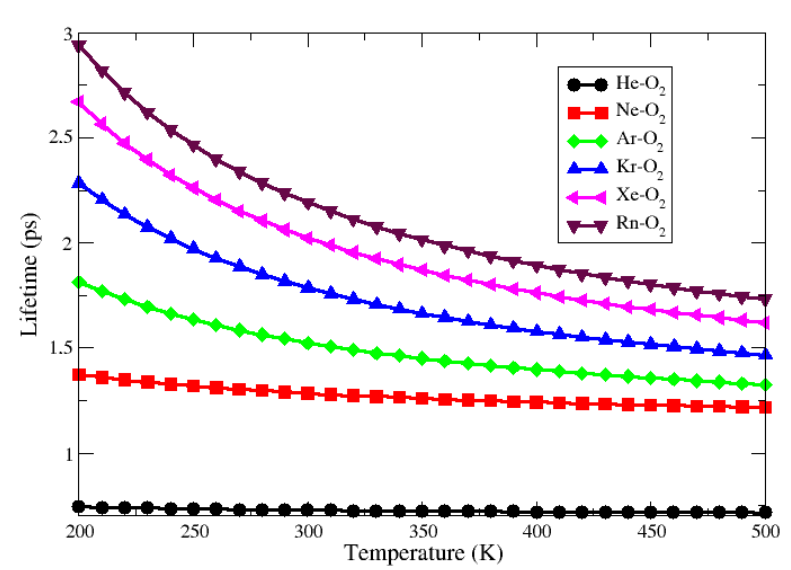
Figure 6. Lifetime behavior as a function of temperature for the Ng–O 2 compounds obtained through ECF